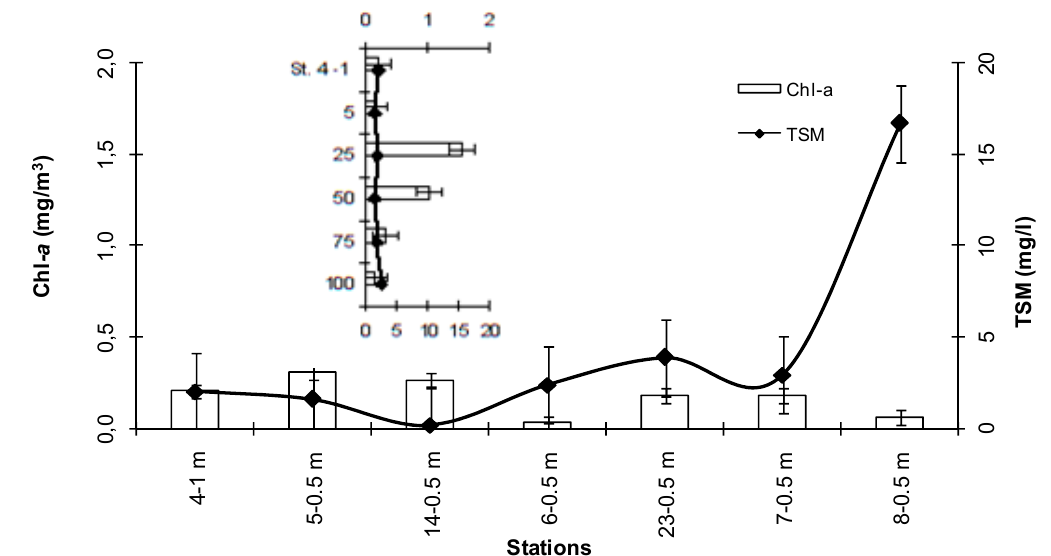
Figure 4. Mean values ± S.E. of Chl -a and TSM concentrations measured along the Kongsfjorden transect, from the entrance to the glacier, and vertical profile of the station 4 (0–100 m). Total C values were comprised between 103.86 and 293.63 µg/l (st. 6—st. 14, respectively); inorganic C content ranged from 12.57 to 140.35 µgC/l (st. 4–75 m—st. 14, respectively), while the organic fraction from 67.94 to 397.20 µgC/l (st. 8—st. 4–25m, respectively). PON concentrations were on average 5.4 times lower than POC, varying between 12.50 and 60.69 µgN/l (st. 7- and st. 4-25 m